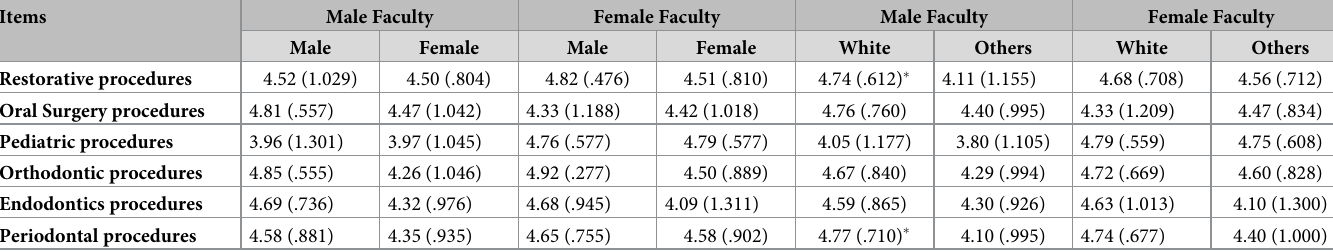
Table 6. Student’s mean (SD) preference scores of working with male or female faculty according to student’s gender and ethnicity. Items